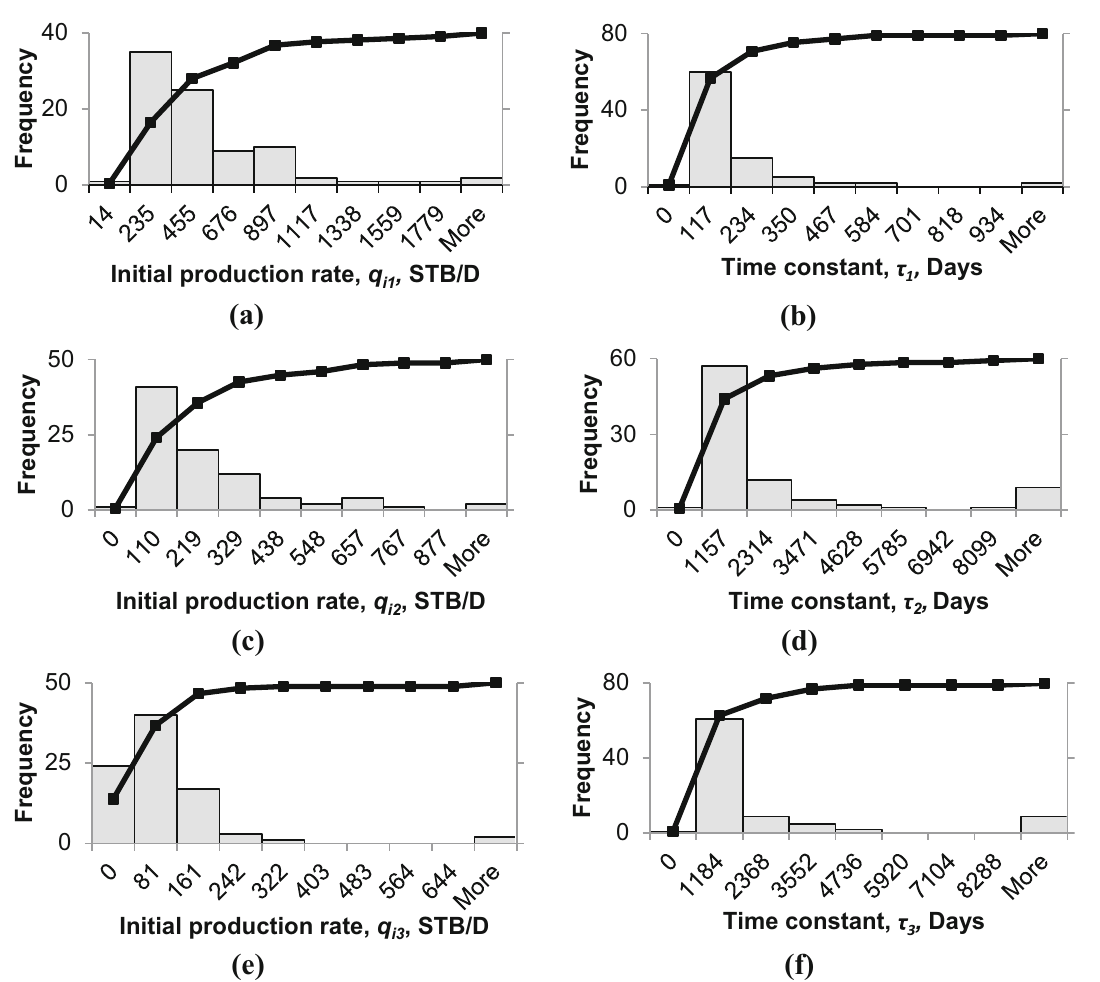
Fig. 4 Probability density function (PDF) and cumulative distribution function (CDF) obtained for the parallel flow model applied to the